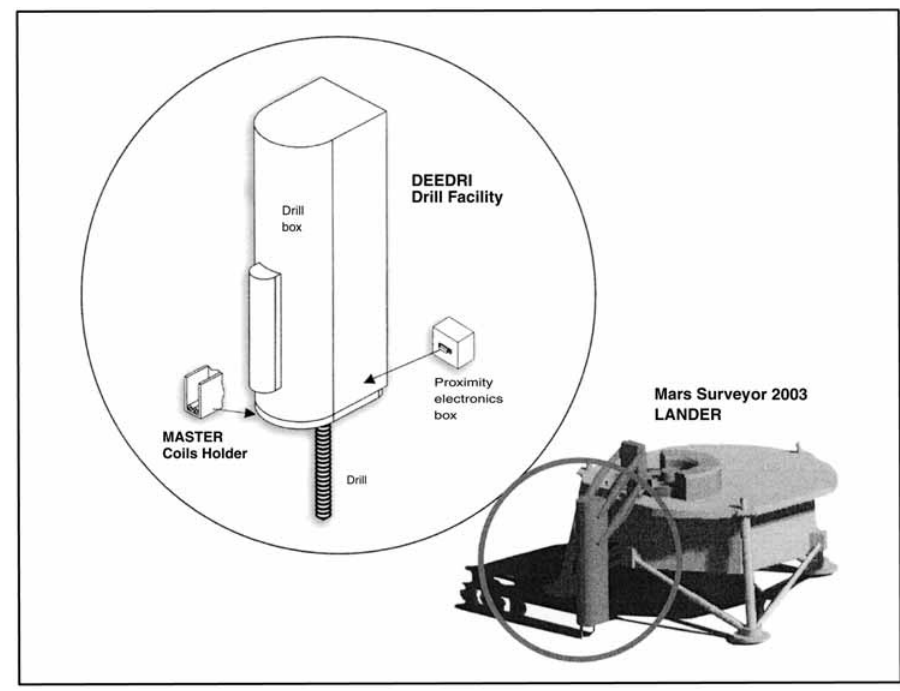
Fig. 1. Allocation of the TDEM instrument on board of